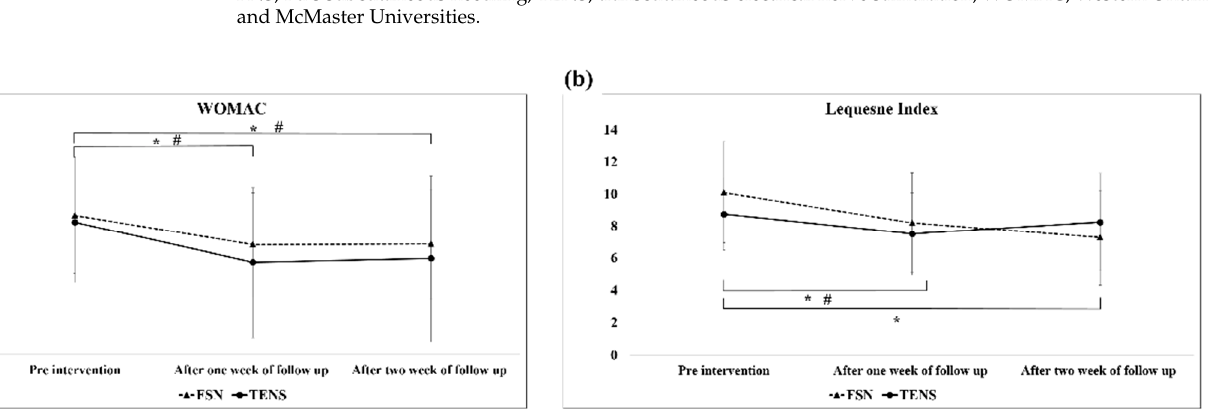
Figure 8. Comparison of WOMAC ( a ) and Lequesne index scores ( b ) between the two groups after each treatment. * represents the FSN group p < 0.05; # represents the TENS group p < 0.05. WOMAC: Western Ontario and McMaster Universities Osteoarthritis Index; FSN: Fu’s subcutaneous needling; TENS: transcutaneous electrical nerve stimulation.